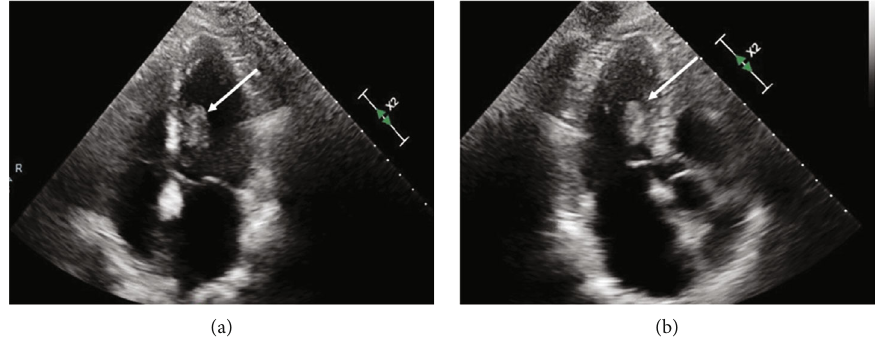
Figure 1: Transthoracic echocardiogram. Panels (a) (apical 4-chamber view) and (b) (apical 3-chamber view) show an echogenic mass located inside the left ventricle attached to the interventricular